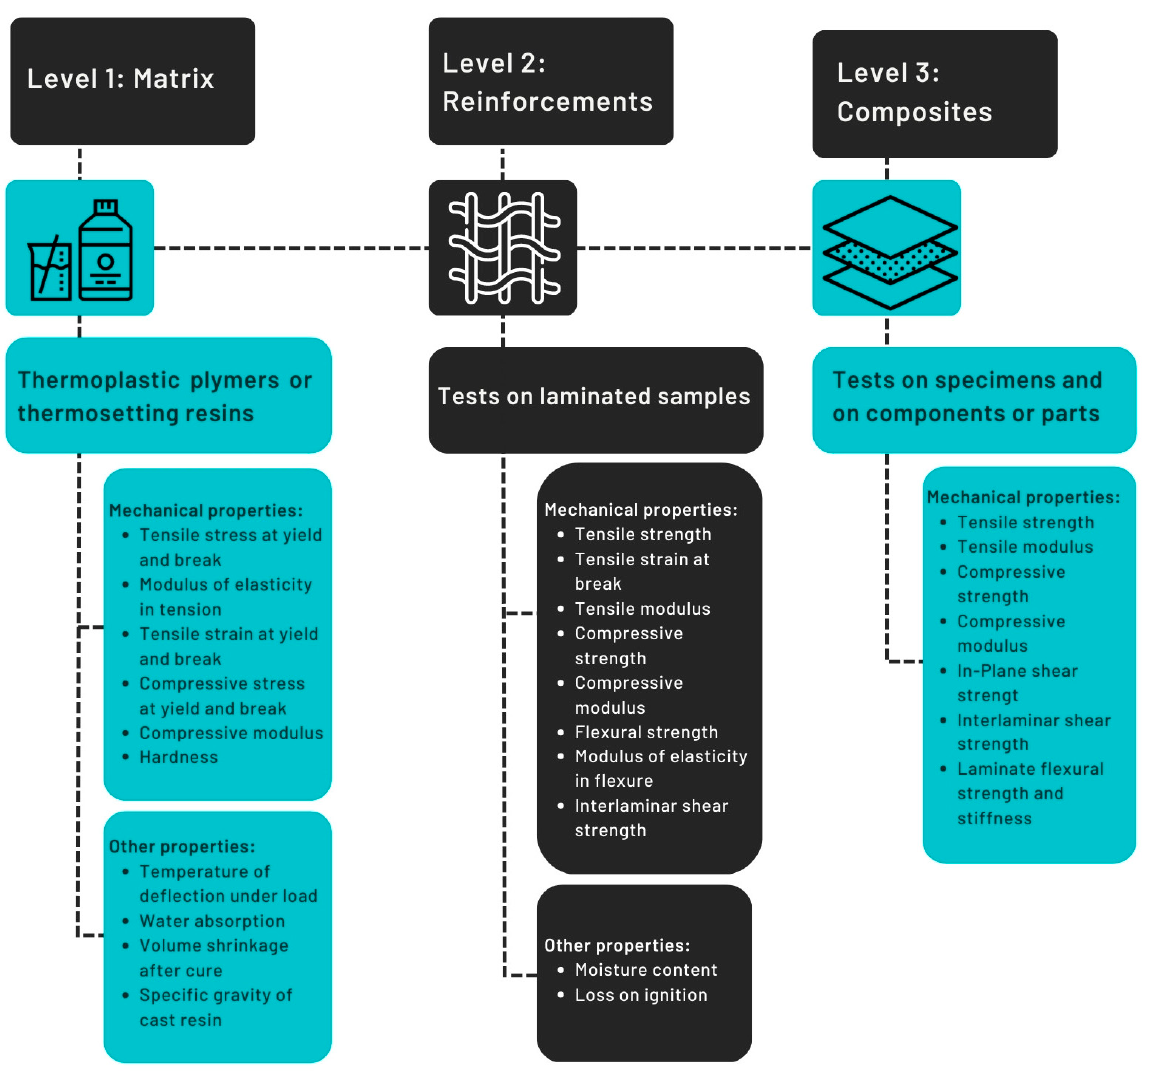
Figure 12. Summary of the properties to be assessed for composites to be used in marine structures, according to classification societies.